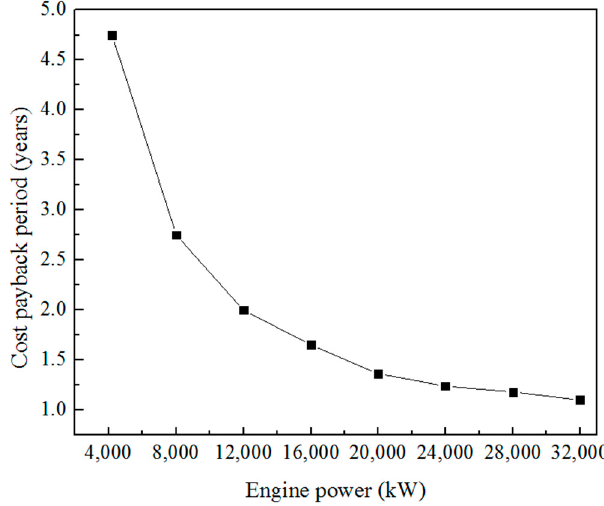
Figure 14. Relationship between engine power and cost payback period with a scrubber installed.